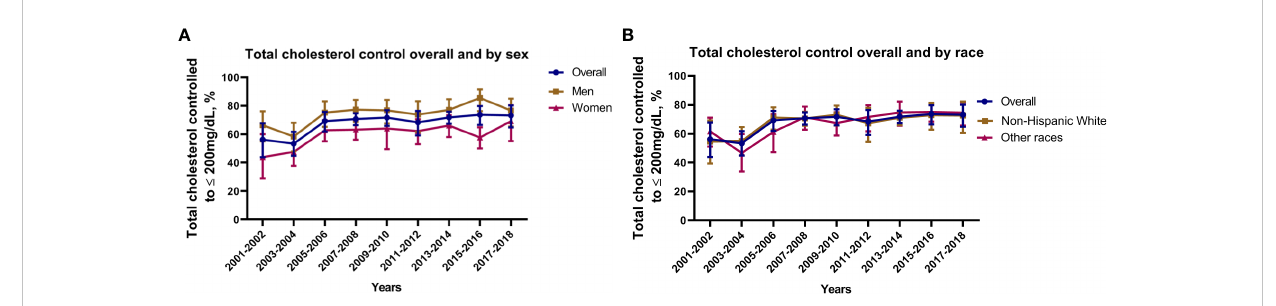
FIGURE 2 Lipid control rate among survivors of stroke and/or myocardial infarction. (A) Lipid control rate based on sex; (B) Lipid control rate based on race. Nationally representative estimates of the survivors of stroke and/or myocardial infarction aged ≥ 20 years in NHANES from 2001 to 2018 (n=3,245, representing a weighted total population of 97,726,894). Estimates are presented as survey-weighted percentage and 95% con fi dence